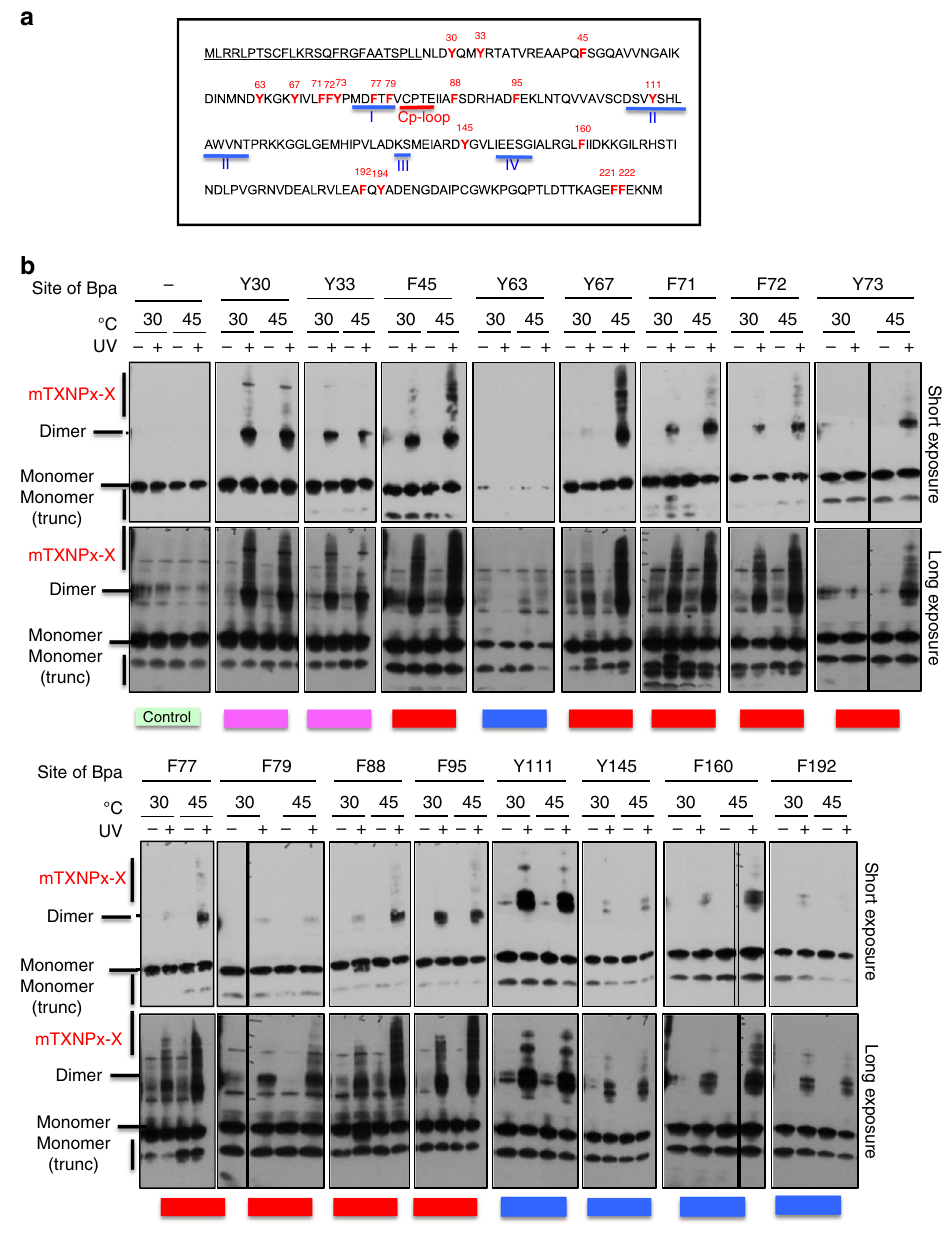
Fig. 3 UV-cross-linking of mTXNPx to client proteins in vivo. a Bpa substitutions in mTXNPx. Phe and Tyr residues (indicated in red) were individually mutated to allow for the site-speci fi c incorporation of the photo-activatable amino acid Bpa. The C p -loop-helix, which contains the peroxidative Cys81 and which is folded when mTXNPx is reduced and decameric, is underlined in red. All regions (regions I – IV) involved in dimer – dimer interactions are underlined in blue. The mitochondrial targeting sequence is underlined in black. The targeting sequence is not present in the in vivo constructs. b In vivo cross-linking of mTXNPx-Bpa variants. E. coli expressing either wild-type mTXNPx or the mTXNPx-Bpa variants were grown at 30 °C and either kept at 30 °C or shifted to 45 °C for 30 min. Afterwards, aliquots of the cells were either left untreated ( − ) or were exposed ( + ) to UV light for 10 min to induce cross-linking. Subsequently, bacteria were lysed and cell extracts were analyzed by western blot using anti-mTXNPx antibodies. Two different exposure times are shown. The two most prominent bands corresponded to monomeric (mTXNPx) and dimeric mTXNPx-mTXNPx, respectively. Additional bands, seen as higher-migrating smear, are suggestive of mTXNPx- E. coli protein cross-links (mTXNPx-X). A representative experiment is shown (results from all experiments conducted are summarized in Supplementary Table 1). Based on the extent of higher migrating smear (i.e., cross-links) upon incubation at 30 °C and/or 45 °C, the residues were classi fi ed into three groups: Group 1: Bpa-variants that cross-link more extensively upon incubation at 45 °C compared to 30 °C (red); Group 2: Bpa-variants that show equal cross-linking at 45 °C and 30 °C (magenta); Group 3; Bpa-variants that either do not show any reproducible higher migrating smear, or show only a small number of discrete higher migrating bands (blue). Bpa-194, Bpa-221, and Bpa-222 variants either produced inconsistent results or were not reliably produced in